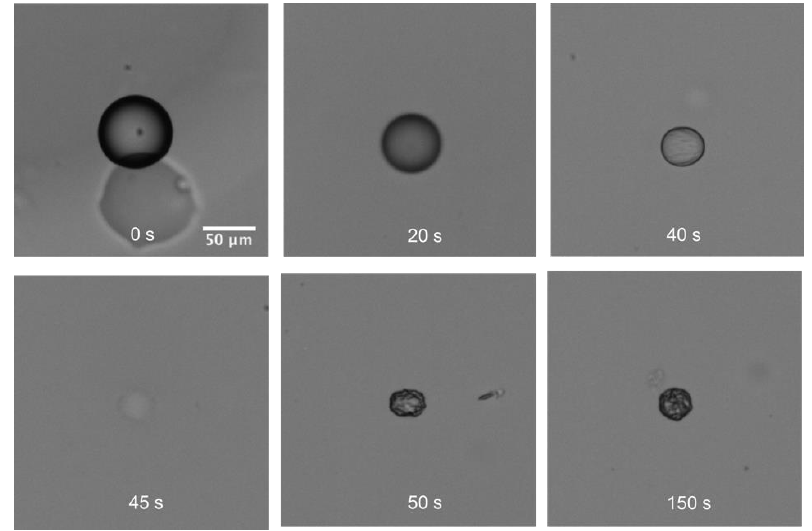
Figure 8. The formation of skin layer of protein during dehydration process with f = 0 (i.e., 𝑎 𝑤 < 0.05).